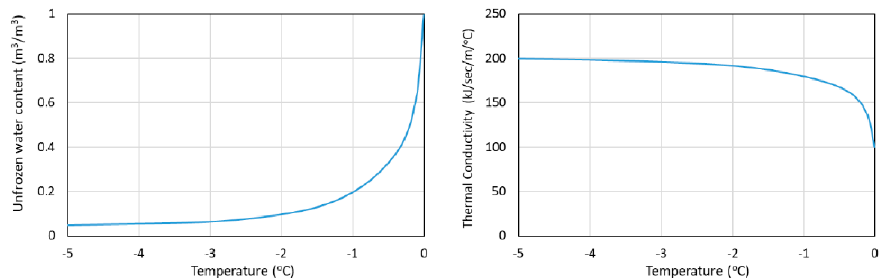
Appl. Sci. 2020 , 10 , x FOR PEER REVIEW Figure 8. Thermal conductivity vs. temperature and unfrozen water content vs. temperature.